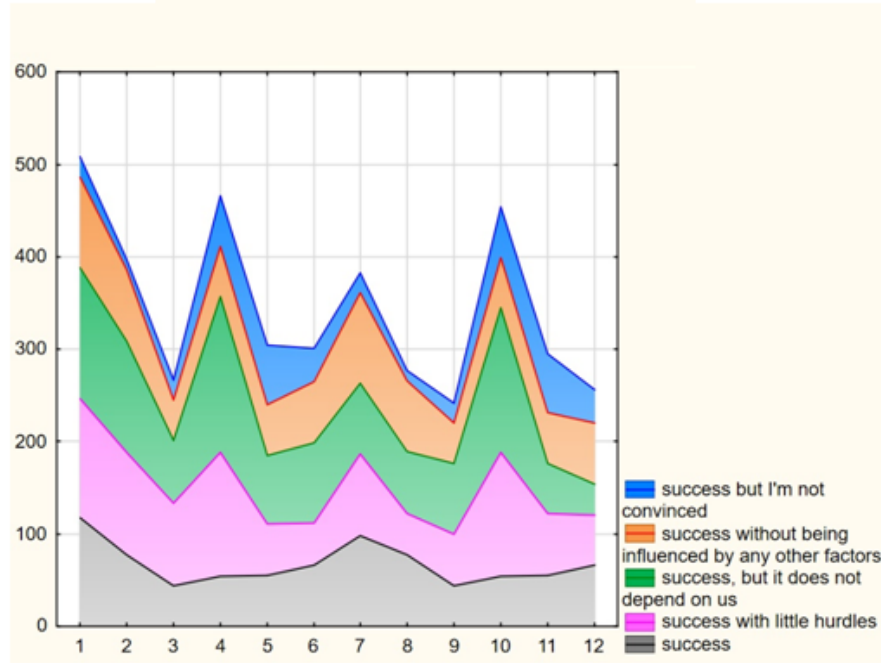
Figure 26. Determination of the research problem of the factor (success) without division into countries.